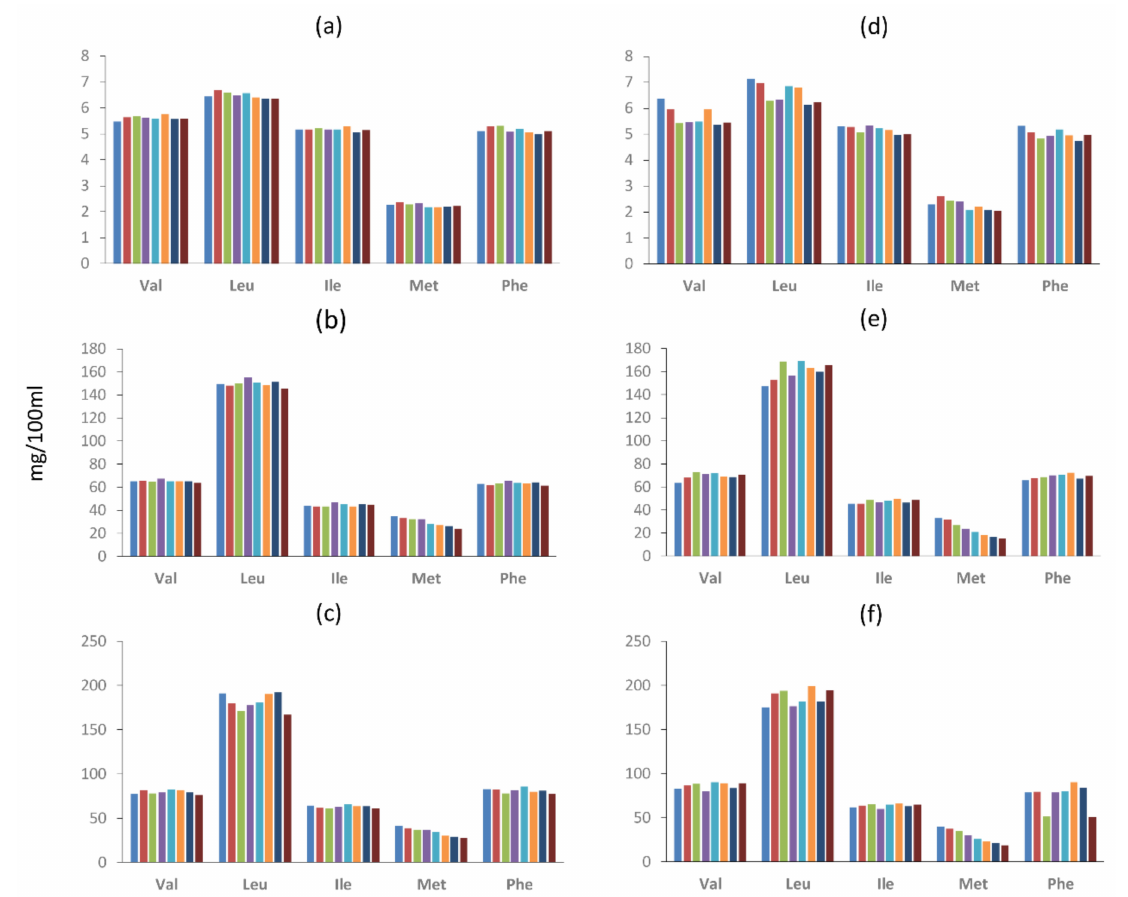
Figure 5. Amino acid concentration in the model systems (mg/100 mL) during incubation at 25 or 37 ◦ C and classified according to the dry curing stages (I-Initial stage, 1D-1st drying stage, 2D-2nd drying stage). ( a ) I-25 ◦ C, ( b ) 1D-25 ◦ C, ( c ) 2D-25 ◦ C, ( d ) I-37 ◦ C, ( e ) 1D-37 ◦ C, ( f ) 2D-37 ◦ C. Bars from right to left in each amino acid represent concentrations at 0, 5, 9, 11 until 35